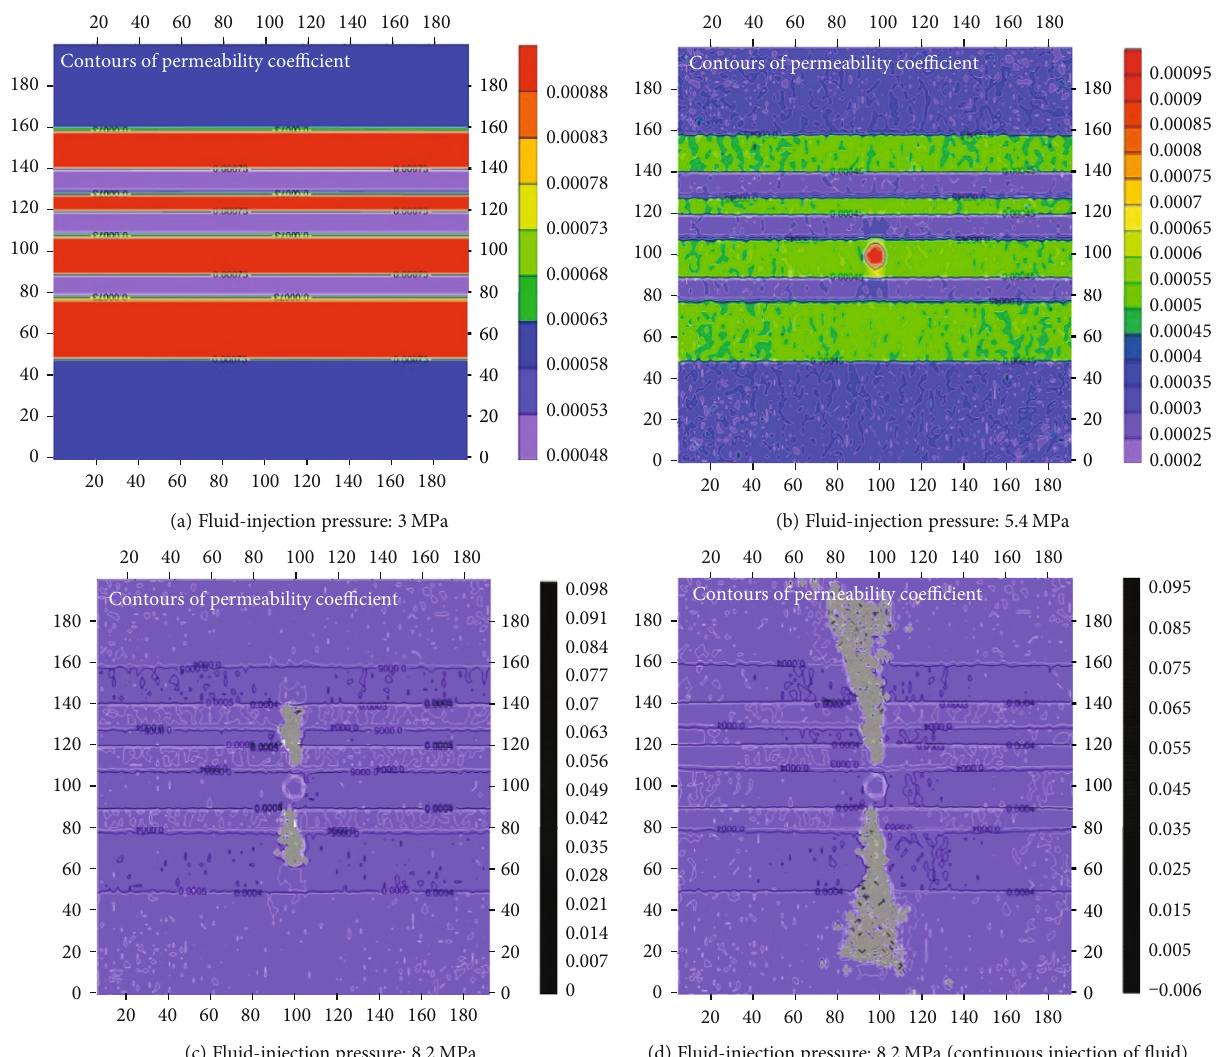
Figure 5: The distribution of permeability coe ffi cient in the vertical direction during hydraulic